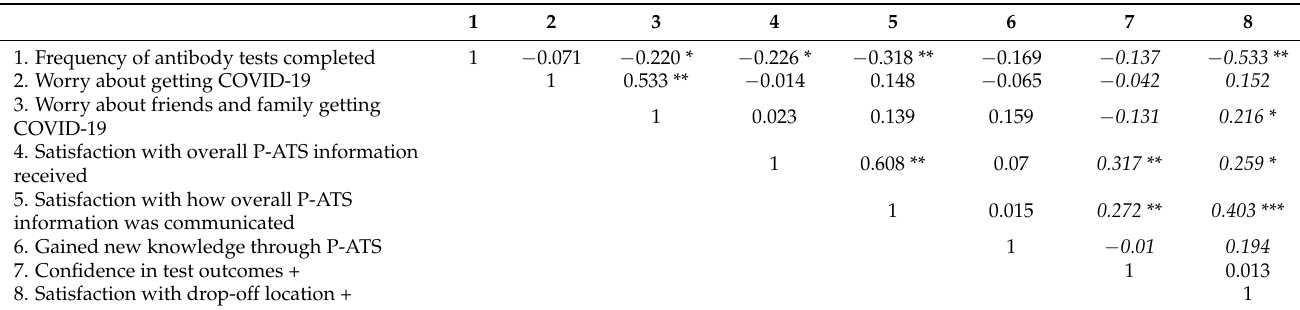
Table 7. Correlation matrix of frequency of antibody test completion, mental health, and programme satisfaction ( n =